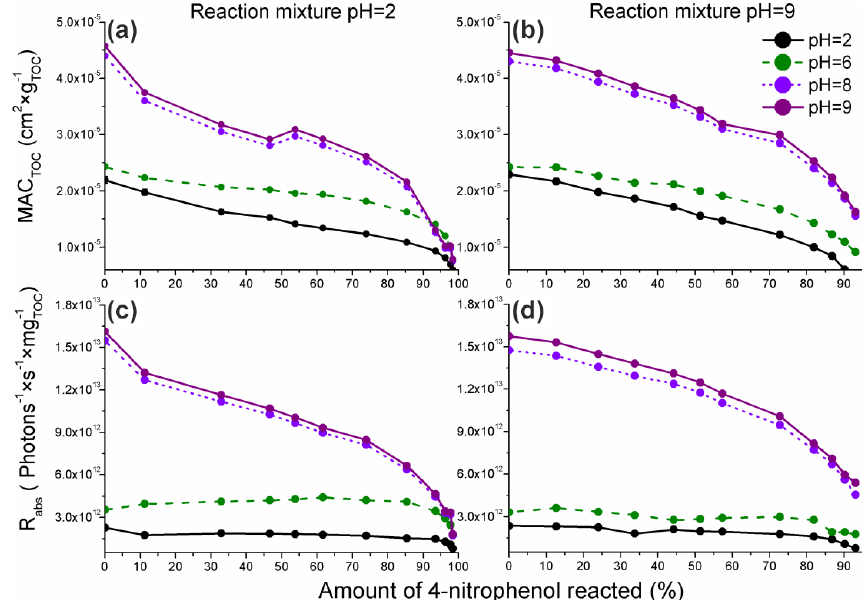
Figure 5. The pH-dependent organic carbon-normalized mass absorption coefficients (MAC TOC ) derived using the integrated absorbance peak for the reaction mixture absorption measured for the reaction of 4NP ( a , pH = 2) and 4NPT ( b , pH = 9) and the corresponding TOC- normalized rates of sunlight absorption ( R abs ) for 4NP (c) and 4NPT (d) . Only the data for pH = 2, 6, 8, and 9 are shown for clarity, and the complete data are presented in Fig. S12. The colors refer to the pH at which the absorbance was measured (Sect. 2.4). The experimental data are represented by points, with the lines provided to guide the eye.